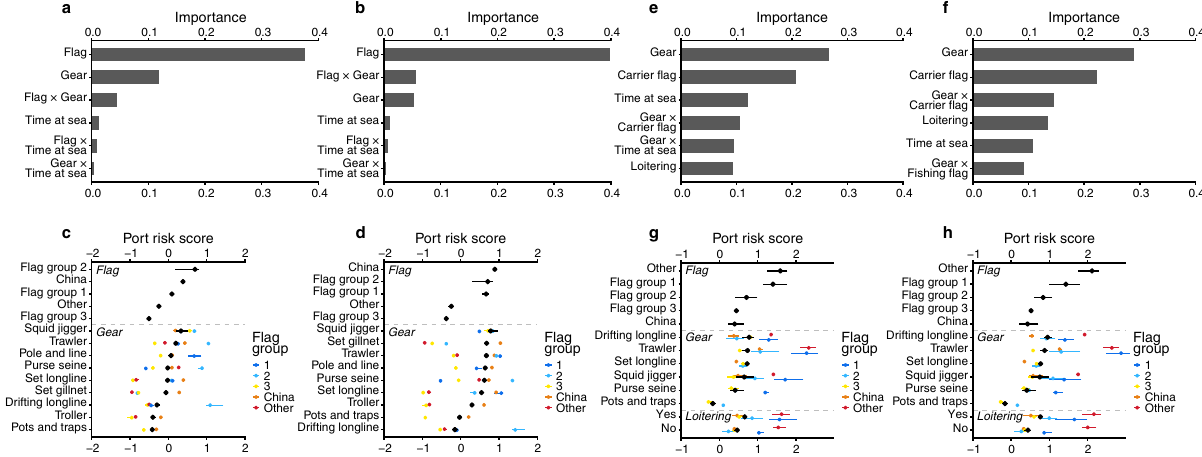
3OtherFlag jiggerFlag group lineTrawlerSquid seinePole and longlinePurse gillnetSet longlineSet trapsTrollerDrifting Pots and Fig. 3 Importance and effects of vessel characteristics in predicting arrival port risks for fi shing and carrier (transshipment) vessels. Predictor importance on fi shing vessels ’ arrival port risk for ( a ) labor abuse and ( b ) IUU fi shing, and effects of the predictors for ( c ) labor abuse and ( d ) IUU fi shing. Predictor importance on carrier vessels ’ arrival port risk for ( e ) labor abuse (top 6) and ( f ) IUU fi shing (top 6), and effects of the predictors for ( g ) labor abuse and ( h ) IUU fi shing. For ( a , b , e , f ), importance of single predictors was calculated as a mean of absolute SHAP (SHapley Additive exPlanations) values of the individual predictor without accounting for the interaction effects; importance of interactions (represented by x between predictors) indicate additional contribution to the model without accounting for the individual effects of each interacting predictor. Flag groups were classi fi ed according to Ford and Wilcox 20 with China as a separate group, and Flag group 1 corresponding to high ownership by countries other than the fl ag state, low fi delity to the fl ag state EEZ and higher control of corruption; Flag group 2 with poor control of corruption, intermediate ownership by countries other than the fl ag state, and low fi delity to fl ag state EEZ; Flag group 3 with low ownership by countries other than the fl ag state, high fi delity to the fl ag state EEZ, and intermediate control of corruption; and Other as fl ag states not included in the original cluster analysis (Supplementary Table 2). Black points represent the estimated port risk score when the predictor is present, calculated by adding the main SHAP values (without interaction effects) to the model baseline. For fi shing gear type, interactions with fl ag groups are also shown ( fl ag groups of fi shing vessels in ( c ), ( d ); of carrier vessels in ( g ), ( h )). For ( c ), ( d ), ( g ), ( h ), points and horizontal lines indicate means and 95% ranges of SHAP values,